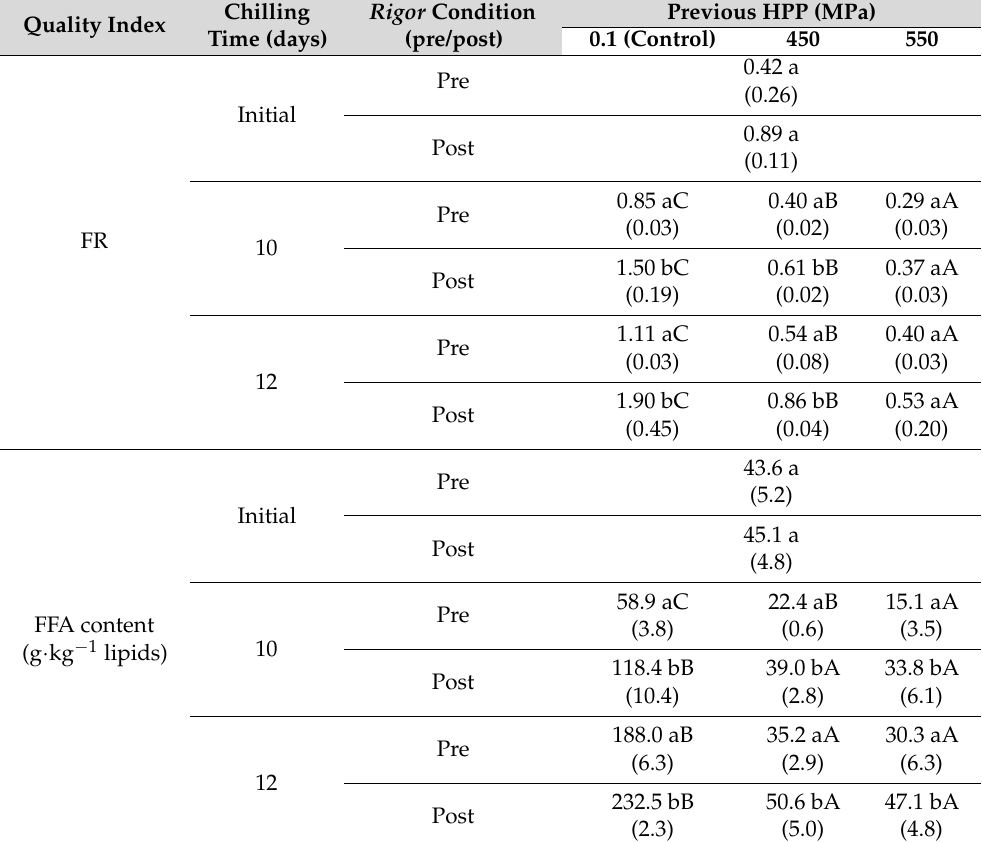
Table 3. Determination * of fluorescence ratio (FR) and free fatty acid (FFA) content in chilled palm ruff corresponding to different initial rigor conditions and previous high-pressure processing (HPP)